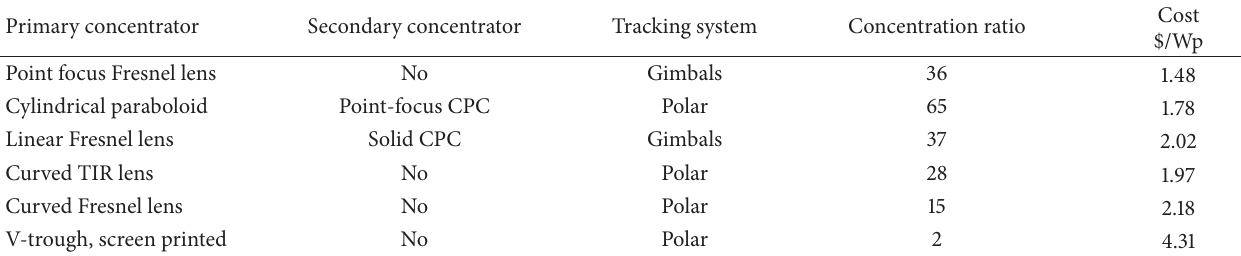
Table 6: Comparative analysis of different CPV systems from economic aspects [49].